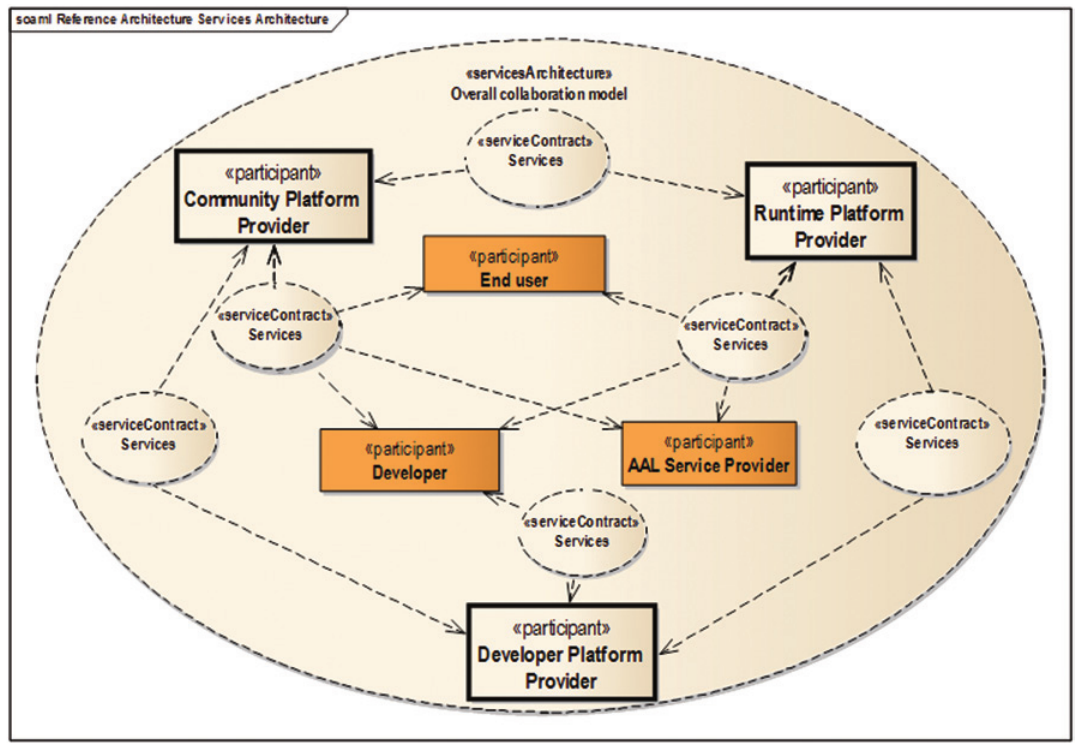
Figure 3: Service Architecture for AAL Main Stakeholders and Their Service